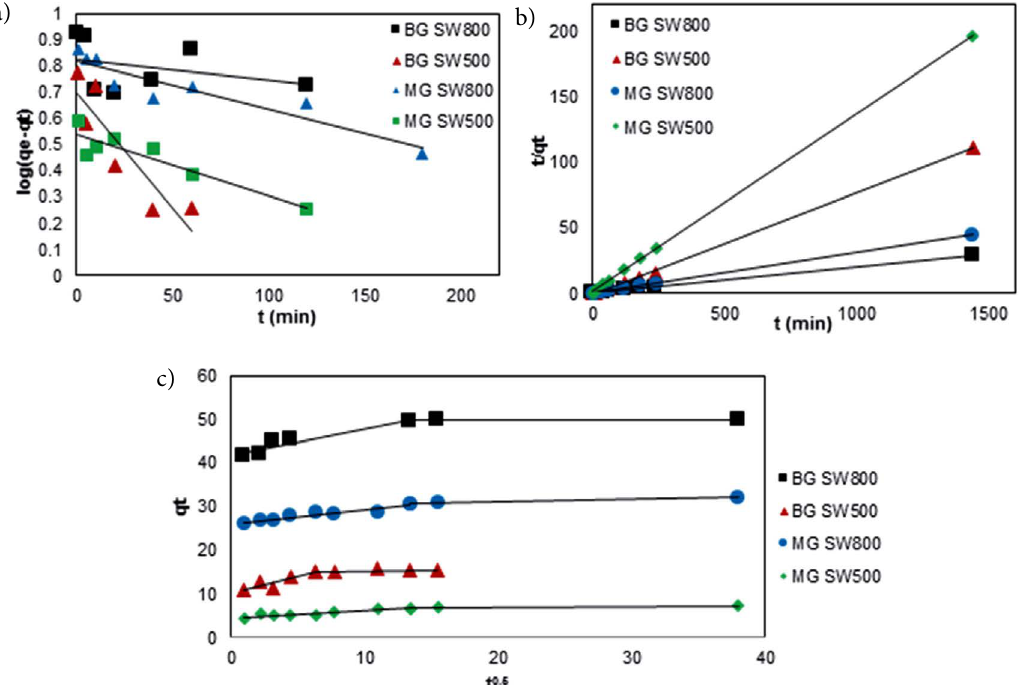
Figure 9. Kinetic studies for BG and MG adsorption a) pseudo first-order kinetic model, b) pseudo second-order kinetic model, c) intraparticle diffusion kinetic model (initial dye concentration 20 mg/L, volume 25 mL, adsorbent dose of BG and MG: 0.4 and 0.6 g/L for SW800 and, 1.2 and 2.4 g/L for SW500, contact time 24 h, temperature 25 °C, n =